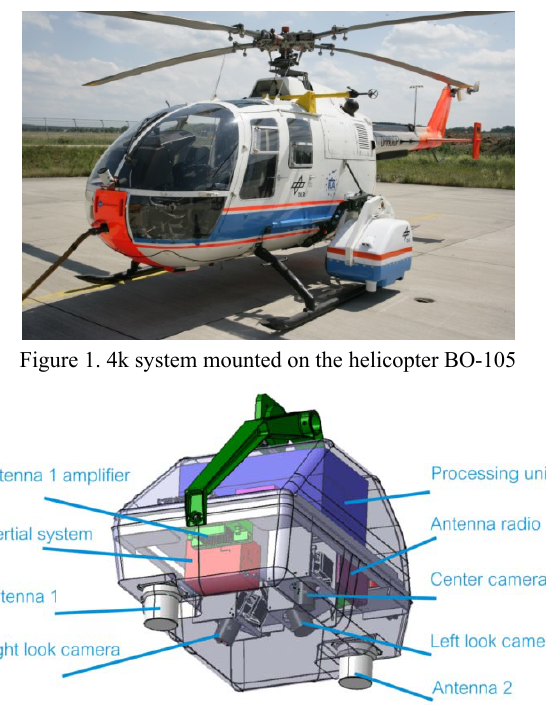
Figure 2. System components of the 4k